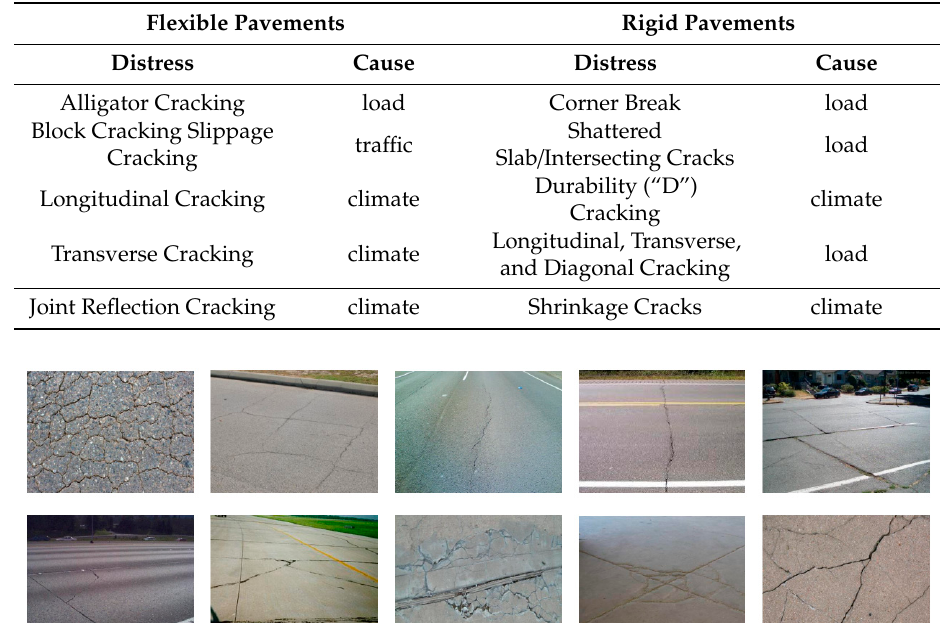
Table 1. Types of cracks in road pavements.